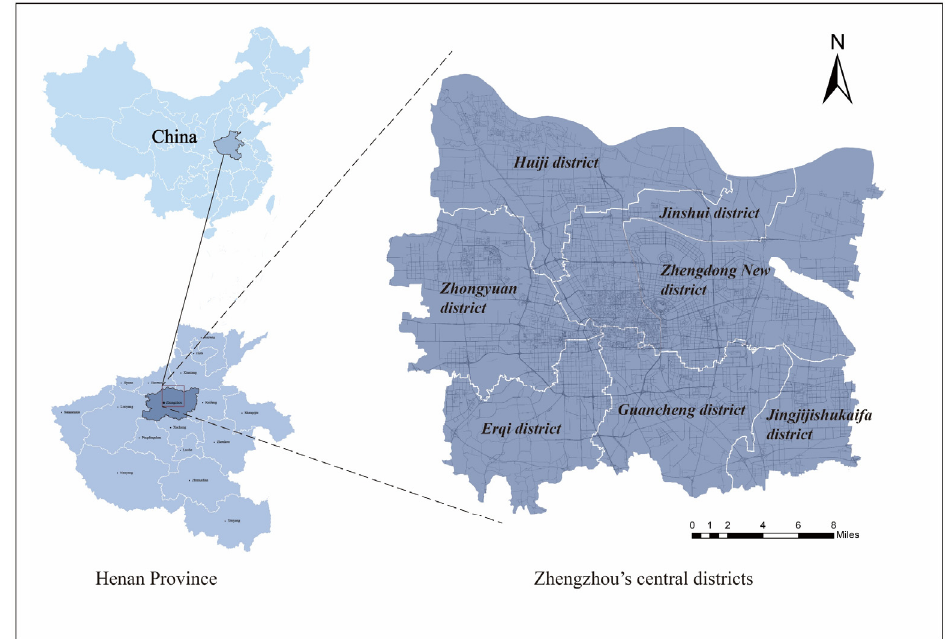
Figure 2. Location of the study site in Zhengzhou, China.